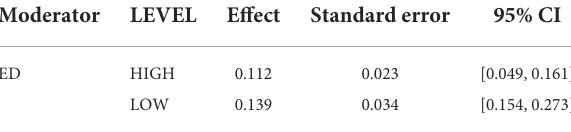
TABLE 4 Test results of conditional process